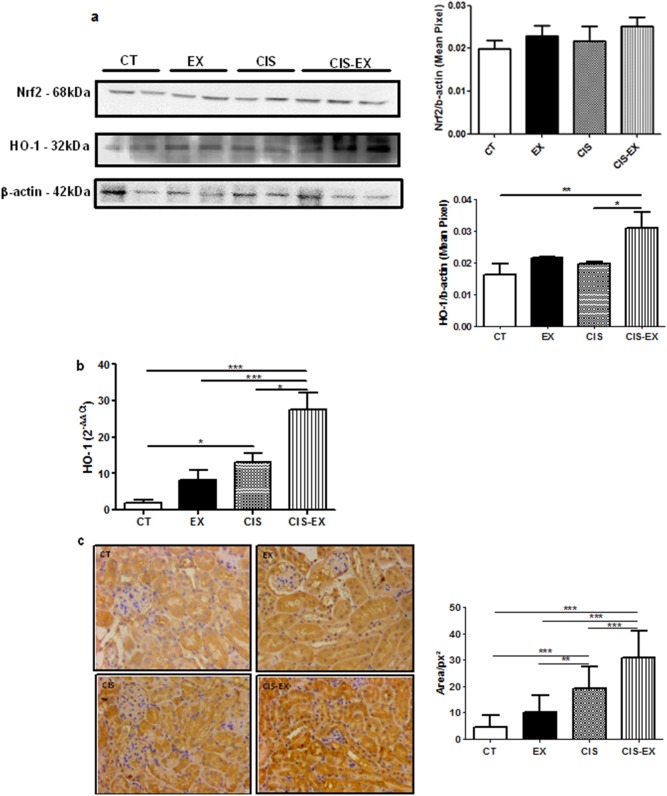
Exercise promotes increased HO-1 expression.Nrf2 and HO-1 expression in the kidney were evaluated by Western Blot (left – representative image and right – quantification). Exercise induced HO-1 gene expression, as confirmed by qPCR (B), and the levels of HO-1 in the renal tissue were analyzed by immunohistochemistry (C, left – representative image and right – quantification). *P<0.05; **P<0.01; ***P<0.001.